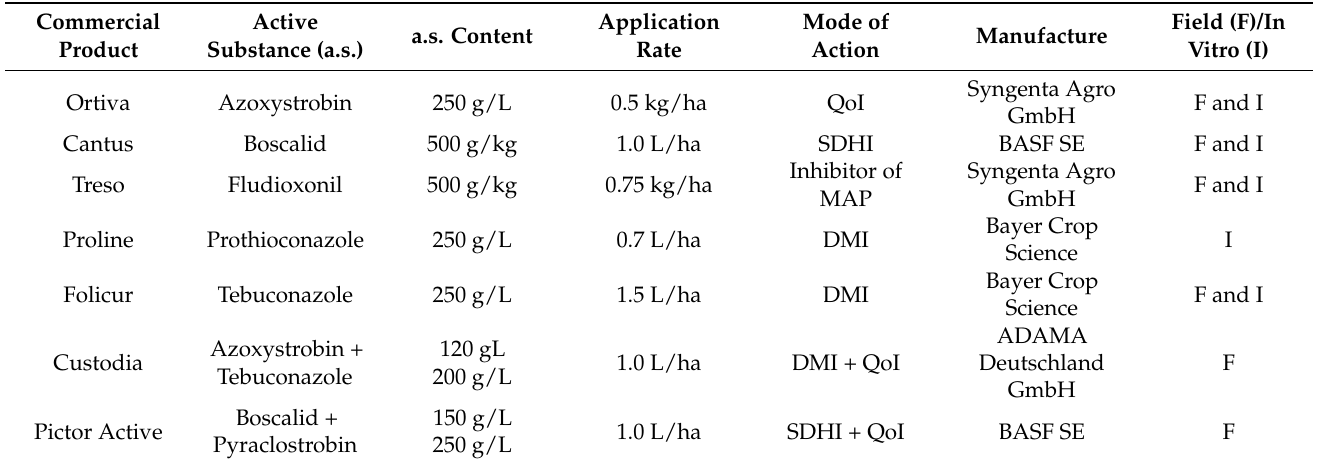
Table 1. Fungicides evaluated under field and in vitro conditions against Sclerotinia sclerotiorum the causal agent of Sclerotinia stem rot in oilseed rape